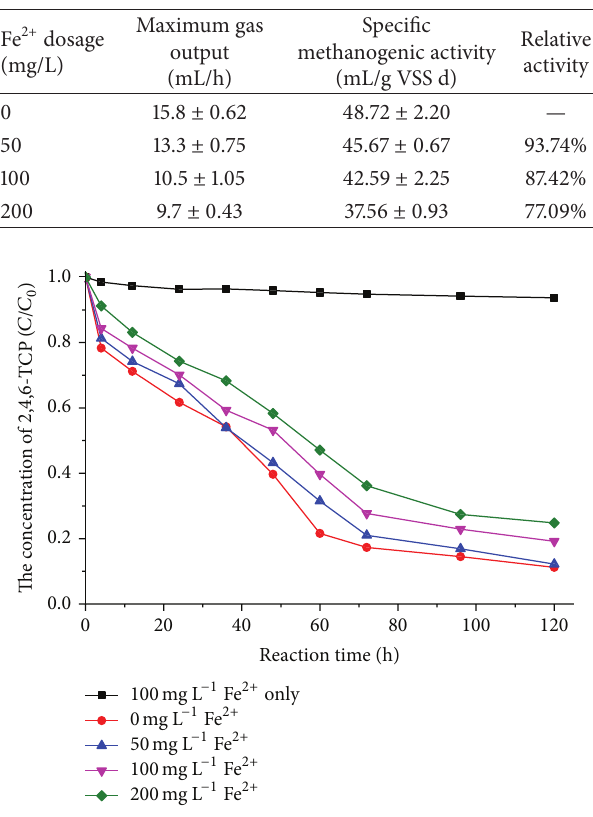
Figure 11: The effect of Fe 2+ on the removal of 2,4,6-TCP in NZVI@SiO 2 -NH 2 -anaerobic granule sludge